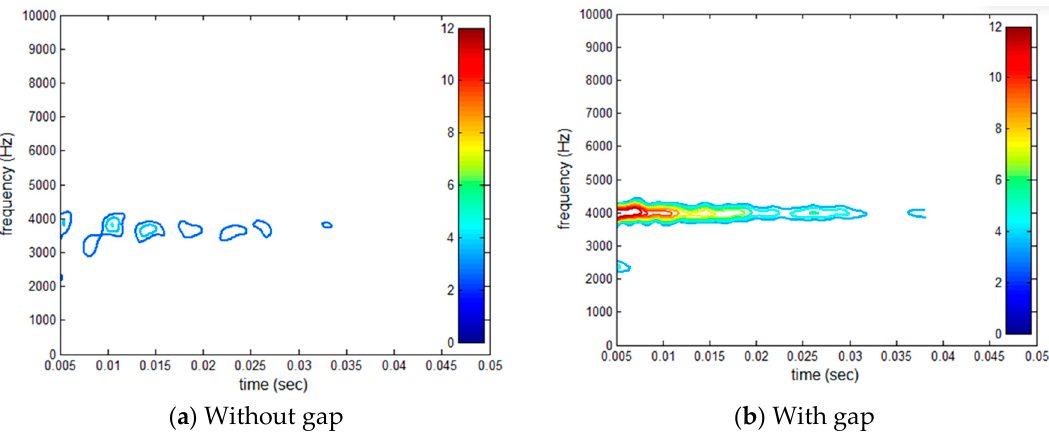
Figure 10. Acceleration contours generated on the concrete slab: ( a ) without gap, ( b ) with gap.